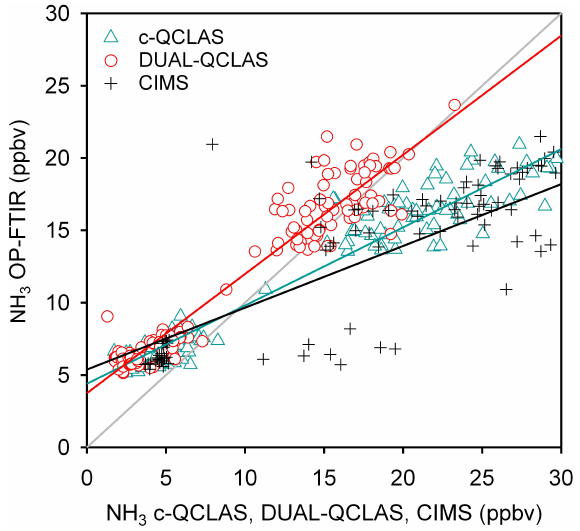
Fig. 5. Scatter plots of OP-FTIR against c-QCLAS, DUAL-QCLAS and CIMS at 2min time resolution, including regression lines and the 1:1 line (grey).